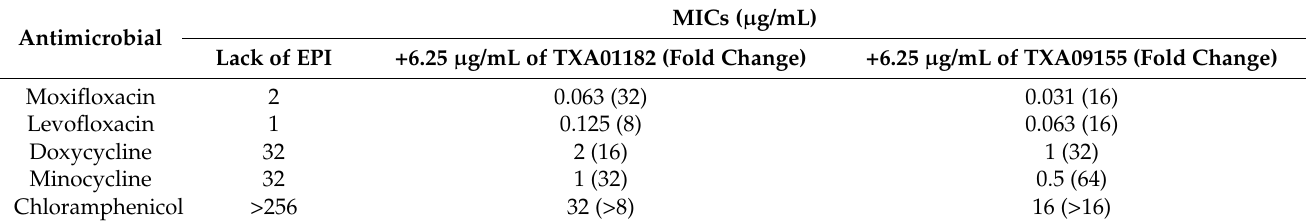
Table 1. Comparison of potentiation abilities between TXA01182 and TXA09155 in wild-type P. aeruginosa ATCC 27853.